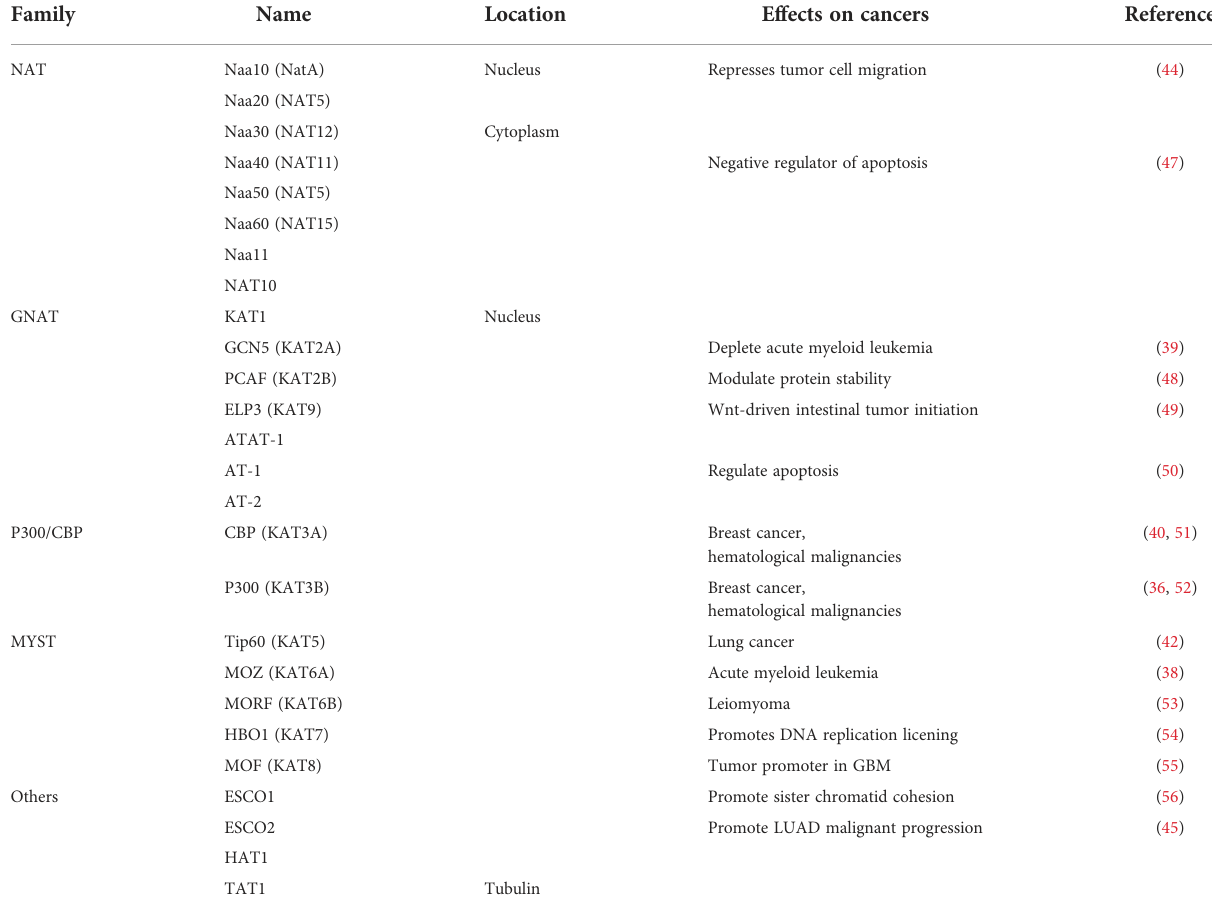
TABLE 1 Classi fi cation, localization and role of acetylases in cancers.